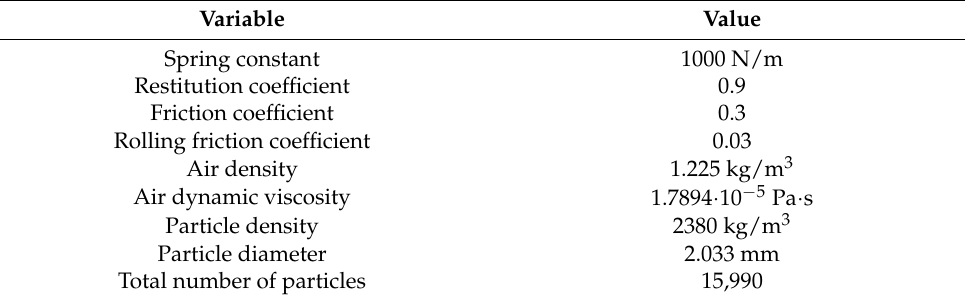
Table 2. Parameters employed in the